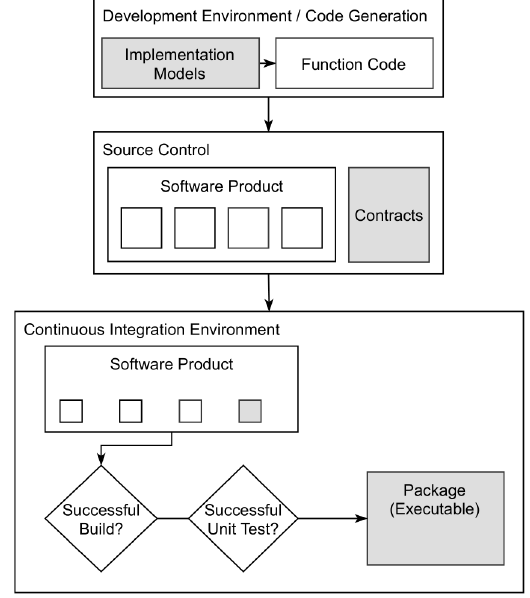
Figure 7. Implementation Pipeline for the Module